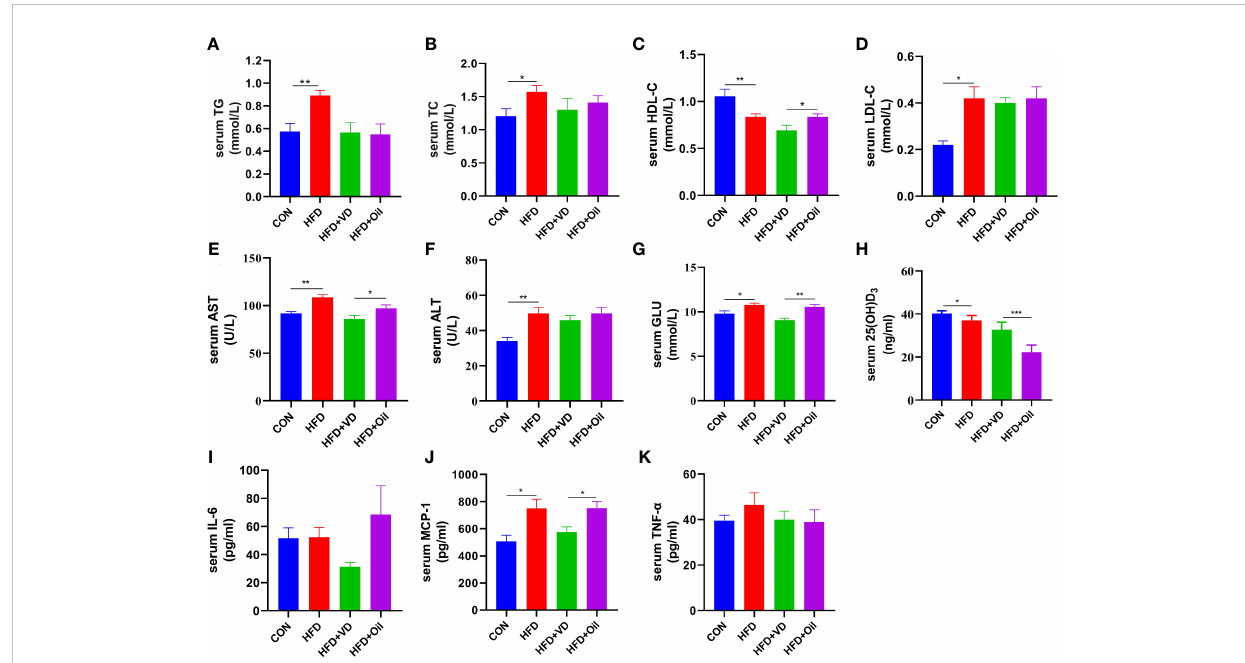
FIGURE 2 The effects of vitamin D in serum parameters of NAFLD rats. (A) serum TG, (B) TC, (C) HDL-C, (D) LDL-C, (E) AST, (F) ALT, (G) GLU, (H) 25(OH)D 3 , (I) IL-6, (J) MCP-1, (K) TNF- a levels. Data were shown as the mean ± SEM. (n=8) *P < 0.05, **P < 0.01, ***P < 0.001.